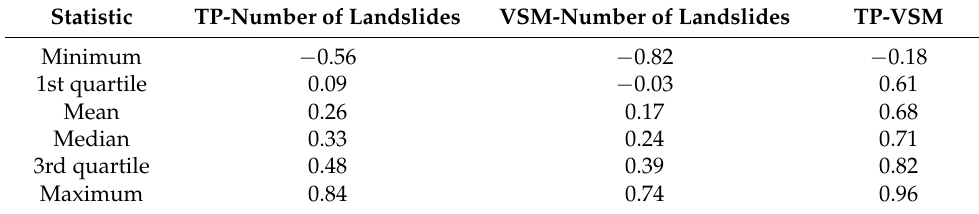
Table 4. Pearson correlation coefficients between pairs of variables (i.e., TP, VSM and number of land- slides) at the annual level. Thus, for the 2010–2017 period average values per year were